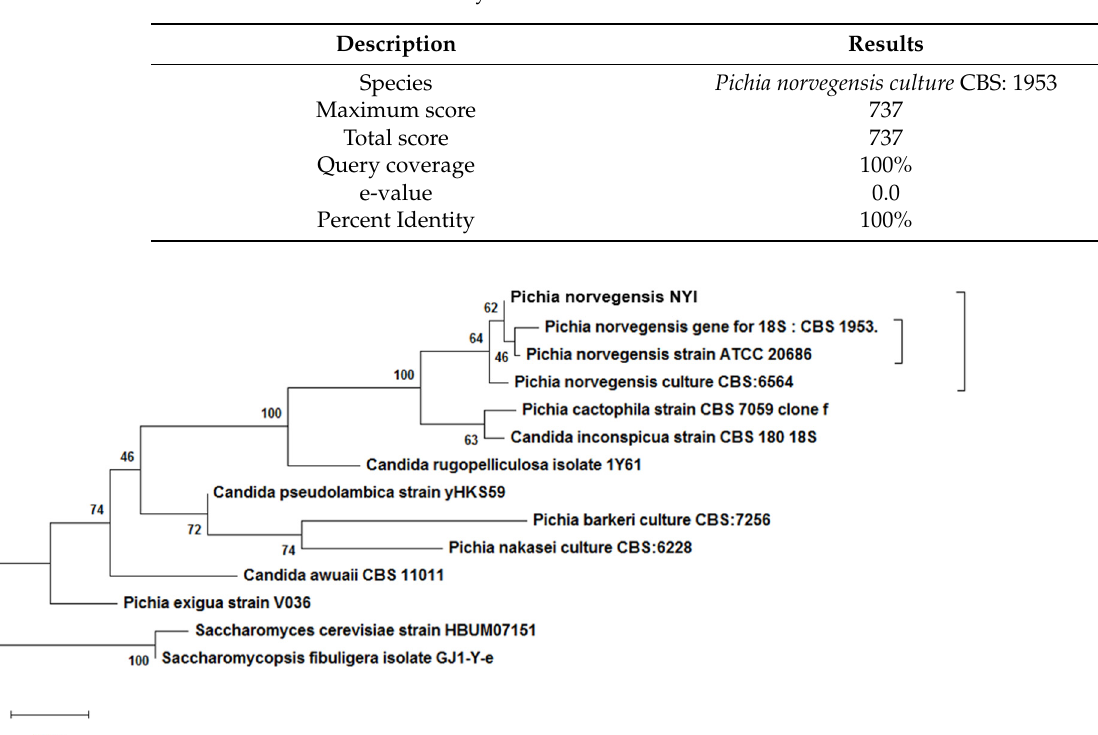
Figure 1. PCR amplification of tofu wastewater native yeast isolate in agarose gel. Table 2. BLAST results of native yeast isolate.